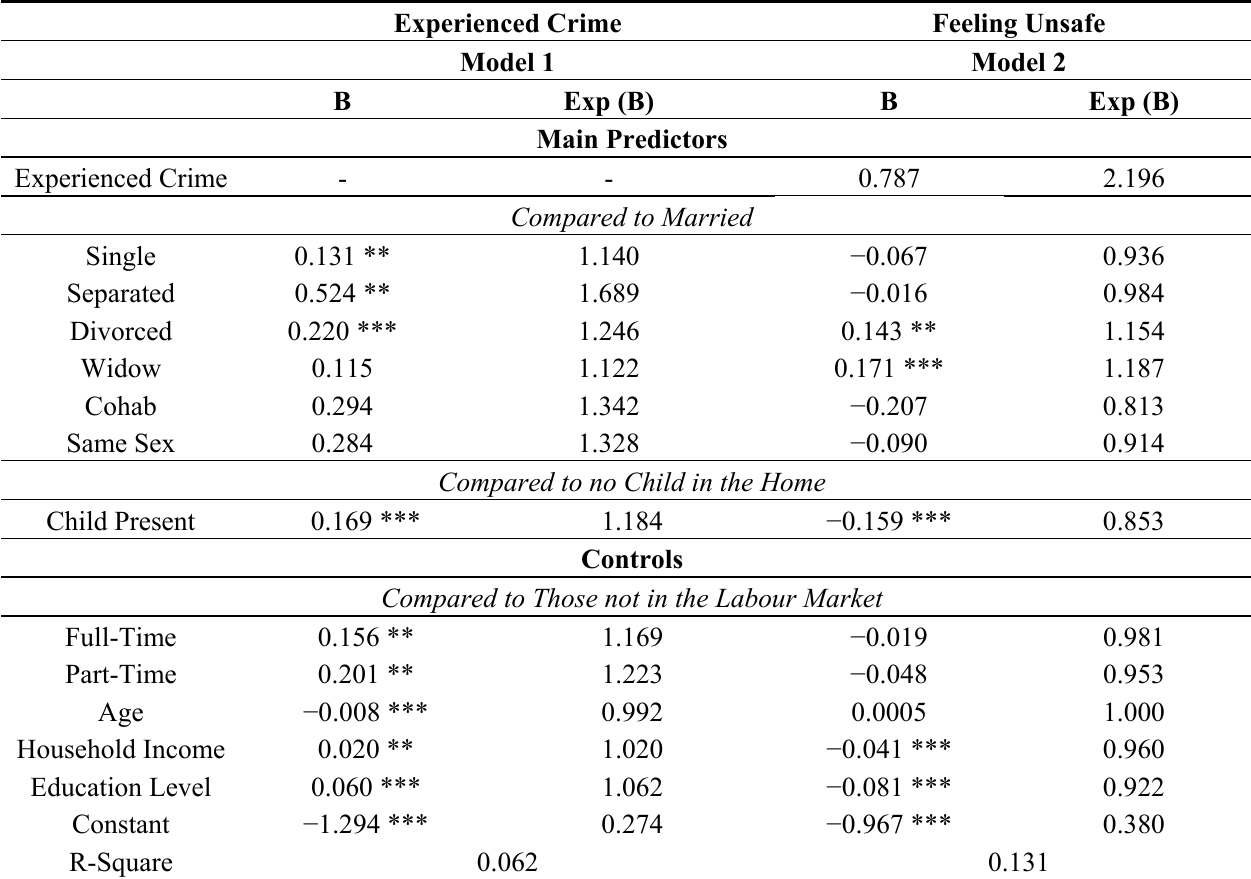
Table 2. Binary logistic regression coefficients for experiencing a burglary or assault in the past 5 years (ESS n = 28,768)